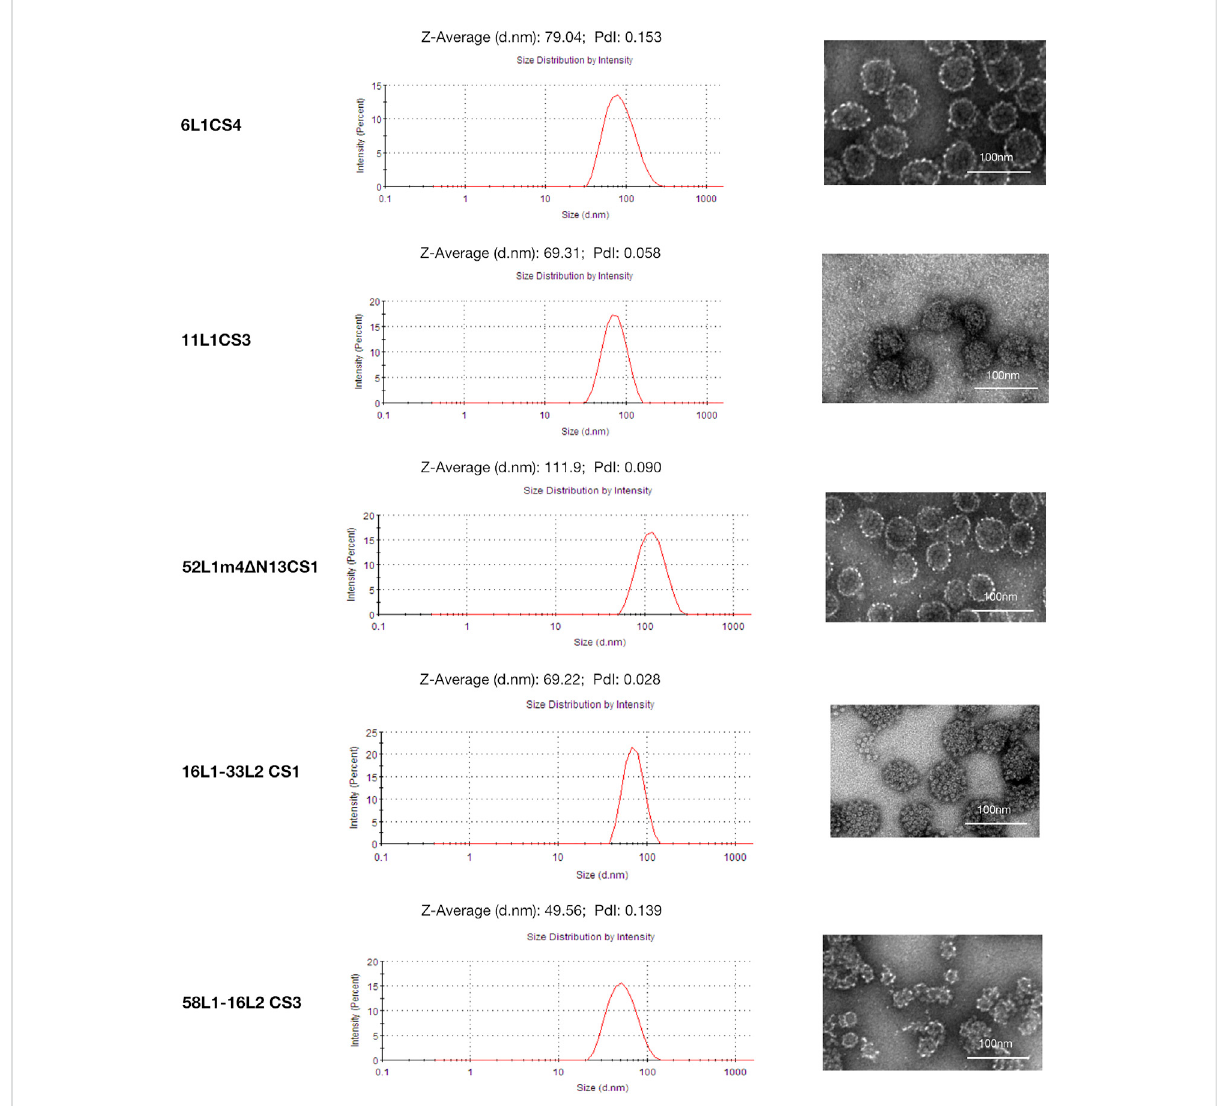
Dynamic light scattering (DLS) and transmission electron microscopy (TEM) analysis of 6L1CS4 VLPs, 11L1CS3 VLPs, 52L1m4 Δ N13CS1 VLPs, 16L1-33L2 CS1 cVLPs, and 58L1-16L2 CS3 cVLPs. Puri fi ed proteins were analyzed by DLS and TEM with a magni fi cation of ×40,000 (6L1CS4, 52L1m4 Δ N13CS1, and 58L1-16L2 CS3) or 50,000 × (11L1CS3 and 16L1-33L2 CS1). Bar = 100